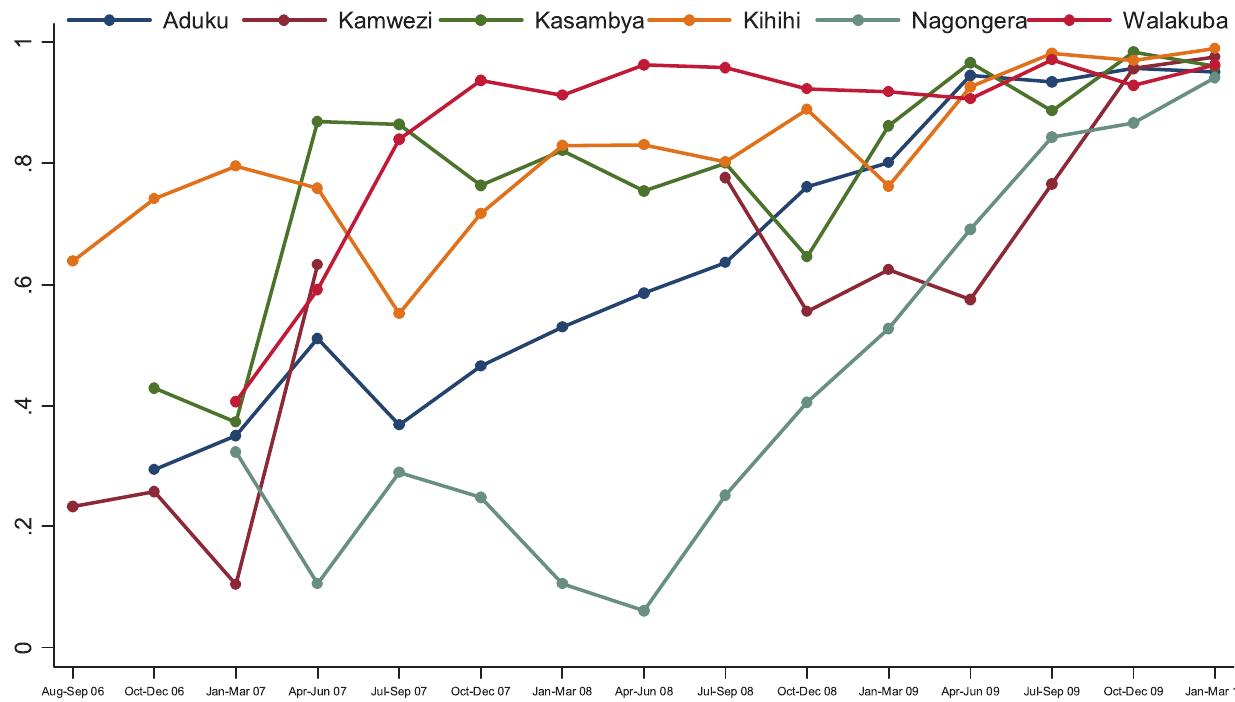
Figure 3. Proportion of patients with suspected malaria with a diagnostic test done by quarter and stratified by site.